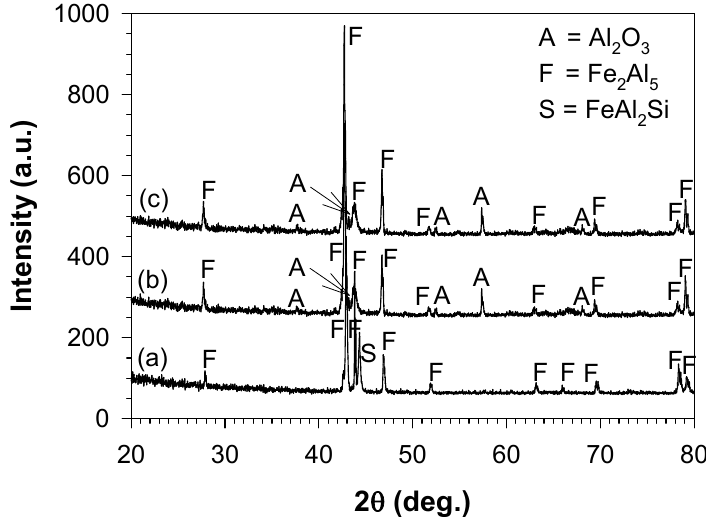
Figure 7. XRD patterns of the aluminide-coated cast iron ( a ) before oxidation, ( b ) after cyclic oxidation in N 2 –12O 2 at 850 °C for 14 cycles and ( c ) after cyclic oxidation in N 2 –12O 2 –10H 2 O at 850 °C for 14 cycles.